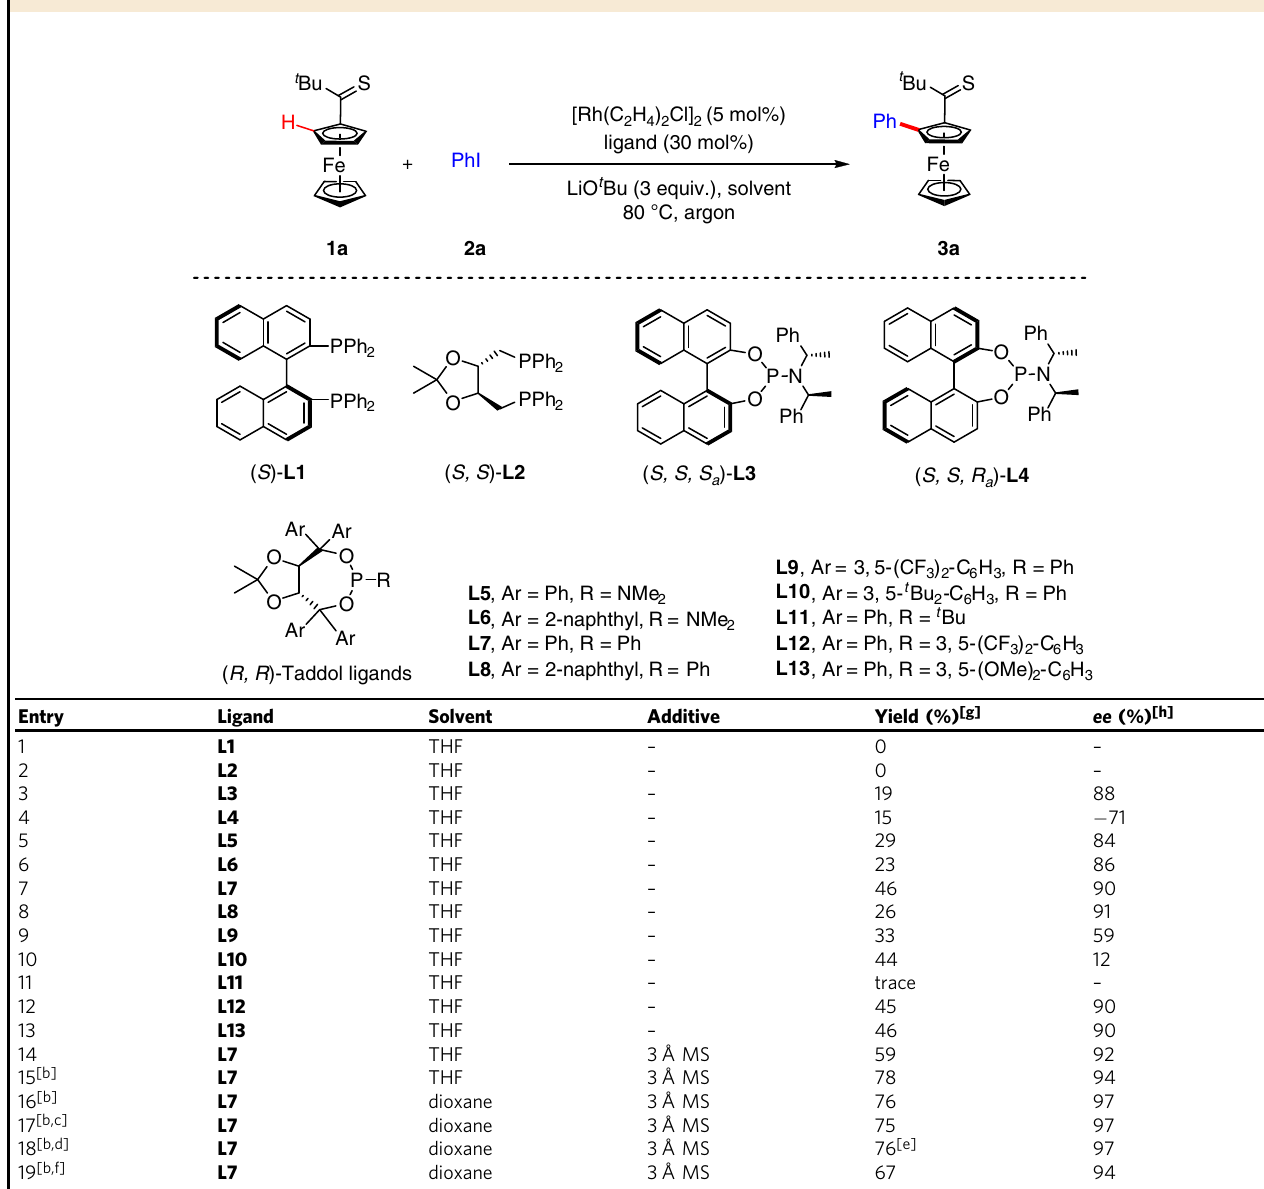
Table 1 Optimization of the reaction conditions